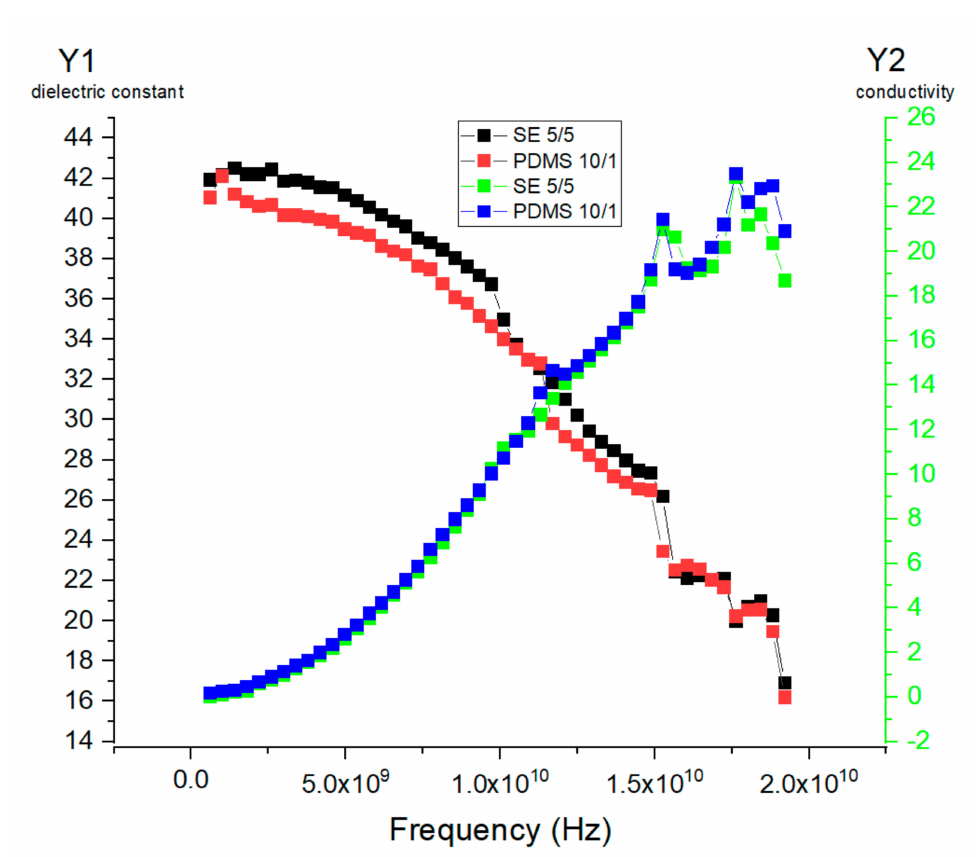
Figure 9. ( Y1 ) The real part of the complex dielectric constant ε (cid:48) r of standard PDMS and SE 5/5. ( Y2 ) The conductivity s/m ( σ ) of standard PDMS 10/1 and SE